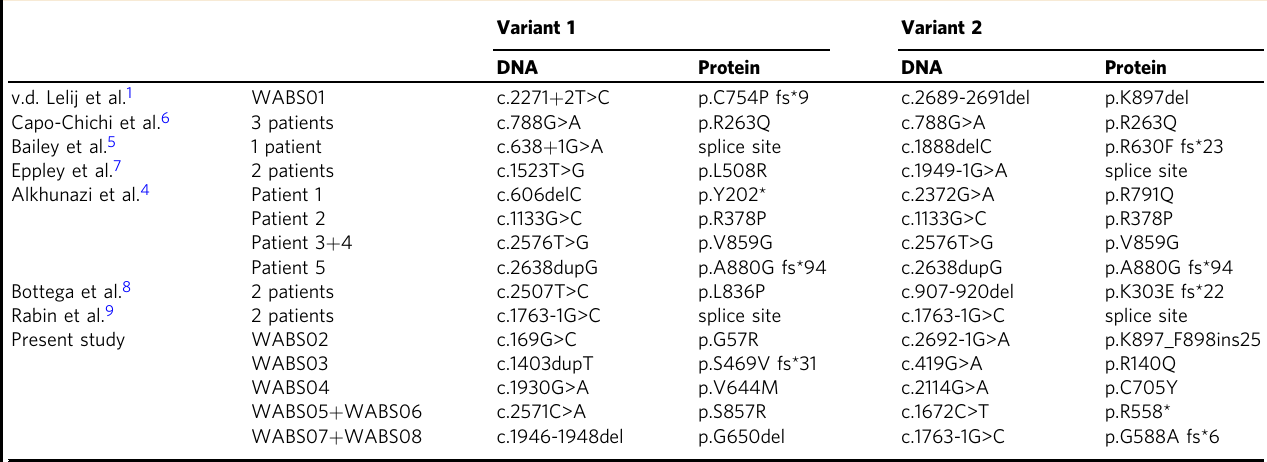
Table 2 Currently reported DDX11 variants in WABS